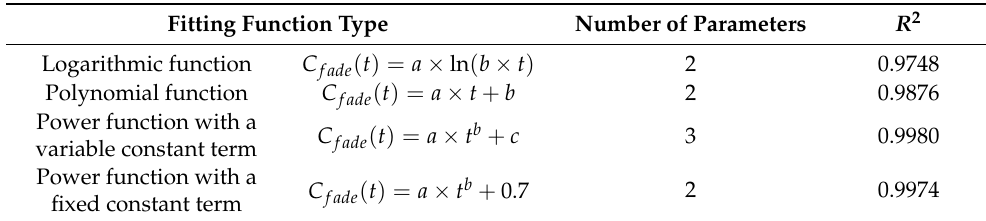
Figure 7. Fitting results between the capacity fade and storage time using different target functions. (Illustrated by the calendar aging test of Case 1). Table 2. The curve fitting coefficients of the capacity fade model considering temperature variation (SOC level is fixed to 50%).